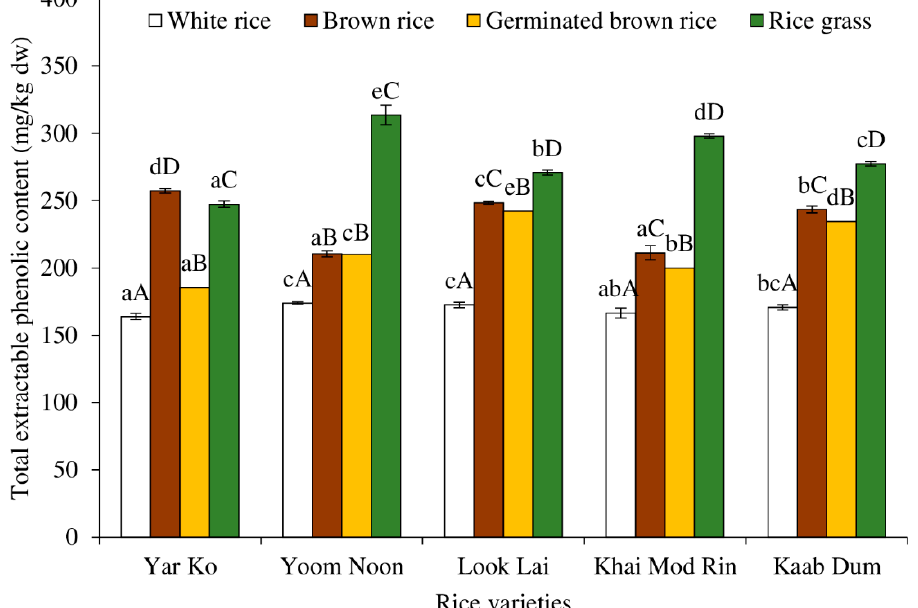
Figure 2. Effect of rice variety and processing condition on total extractable phenolic content of Thai indigenous rice. Bars represent the standard deviations from triplicate determinations. Different lowercase letters within the same processing condition indicate significant differences ( p ˂ 0.05). Different uppercase letters within the same variety indicate significant differences ( p ˂ 0.05).